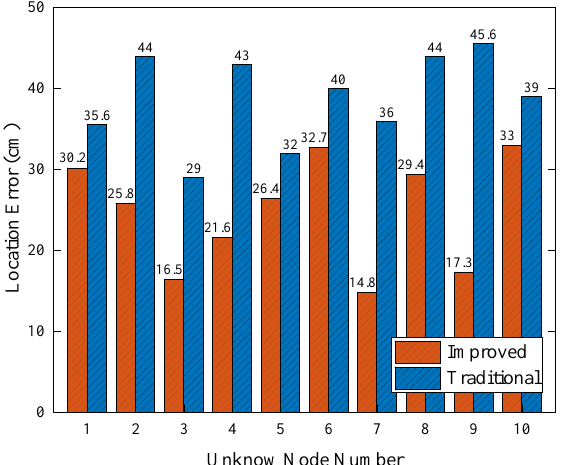
Figure 8. Overall localization